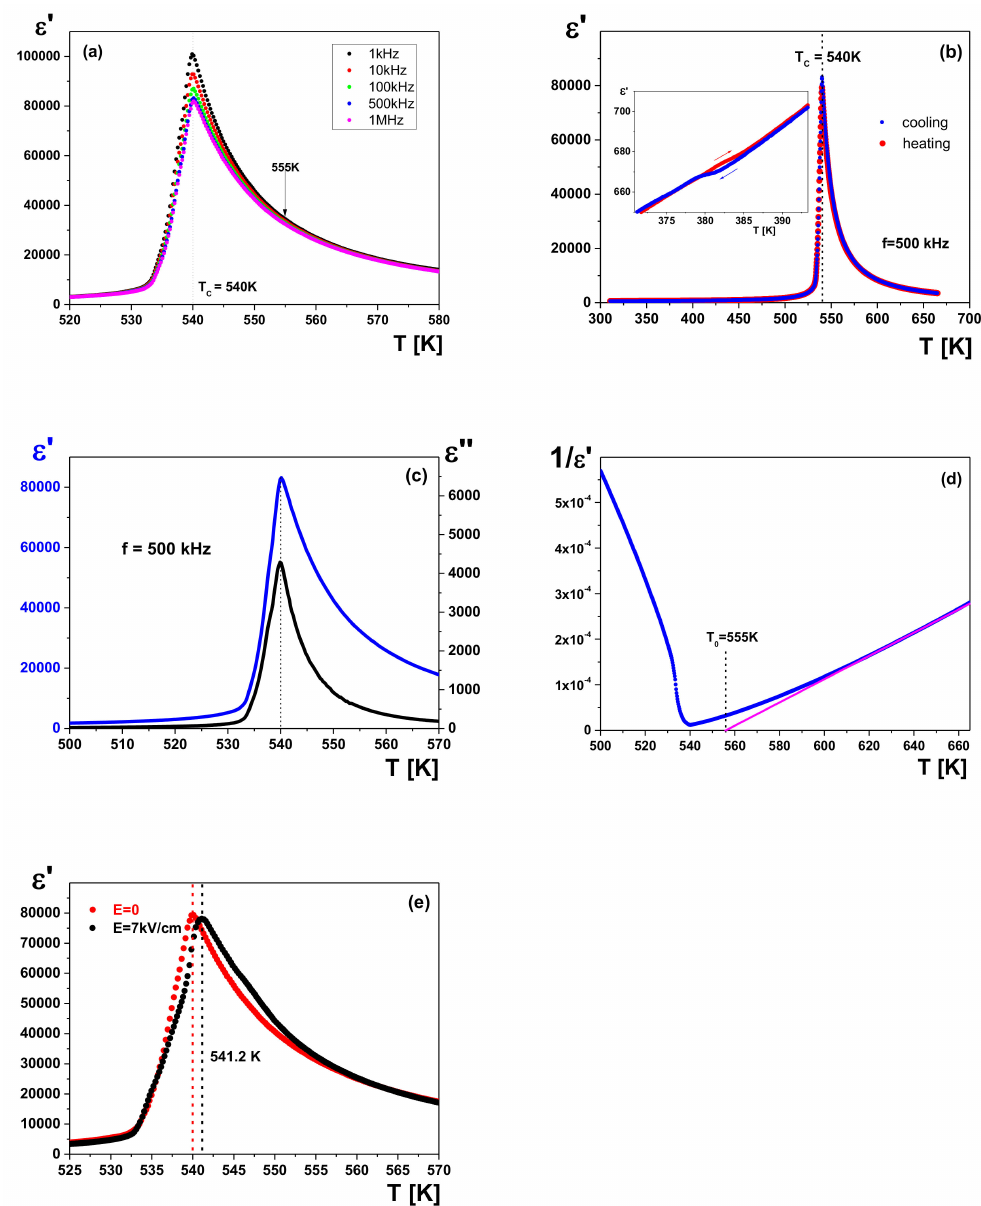
Figure 1. Dielectric characteristics: ( a ) the temperature dependence of the real part of the complex permittivity ε ’ of a single PbZ 0.87 Ti 0.13 O 3 crystal at the di ff erent probe frequencies; ( b ) anomalies on ε ’(T) runs on heating (in red) and cooling (in blue) connected with transitions between the ferroelectric and paraelectric phase at T C , and between two ferroelectric phases FE 1 and FE 2 (inset); ( c ) real ε ’ (blue) and imaginary ε ” (black) part of complex permittivity, corresponding to transition from centrosymmetric to non-centrosymmetric phase; ( d ) the inverse of the real part of the complex permittivity measured at 500 kHz. The high-temperature data with a fit to the Curie–Weiss law; ( e ) The influence of d.c. poling electric field on ε ’(T) run on heating, measured at 500